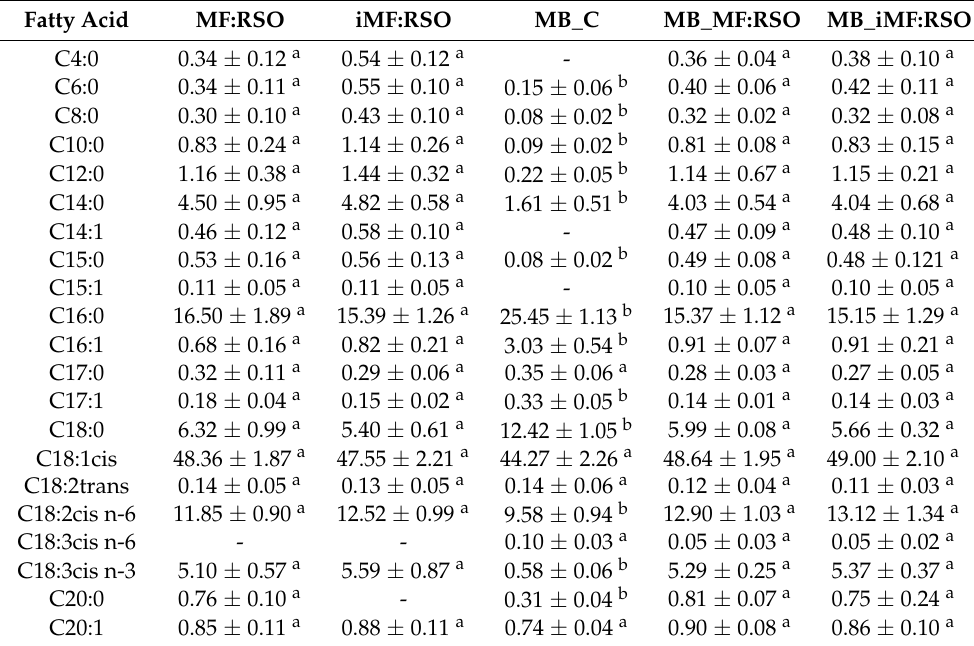
Table 2. Fatty acid compositions (%) of fats used in the model meat batters and extracted from the model meat